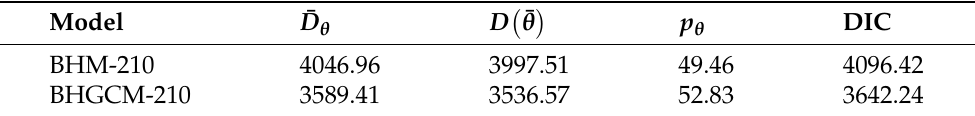
Table 2. Results of using the DIC for models BHM-210 and BHGCM-210.